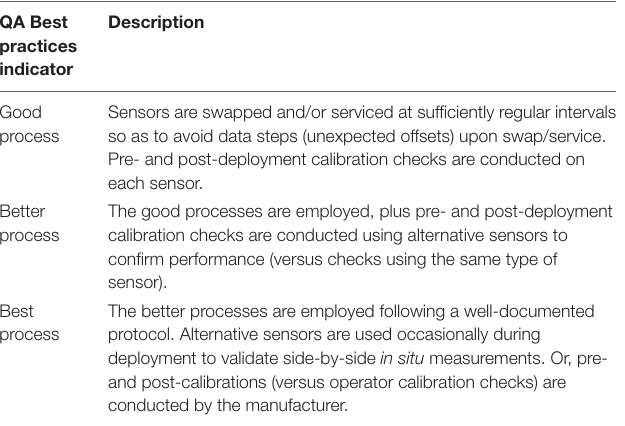
TABLE 3 | Best practices indicator for